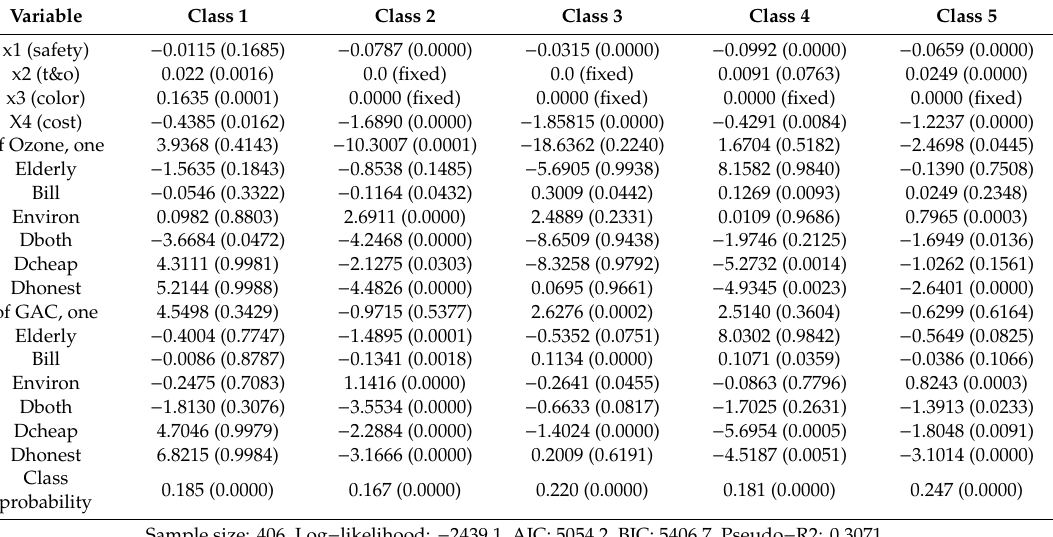
Table 3. Estimation of the coe ffi cients of the ANA1 (Attribute Non-Attendance) model.